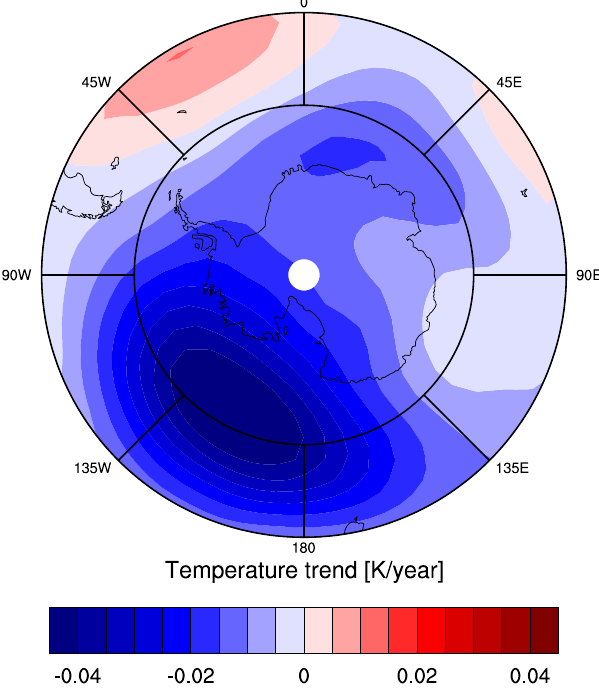
Fig. 15. Trends (1960 to 2049) in temperatures at 70hPa in July from NIWA-SOCOL. The outer margin lies at 45 ◦ S, and 60 ◦ S is marked as inner black